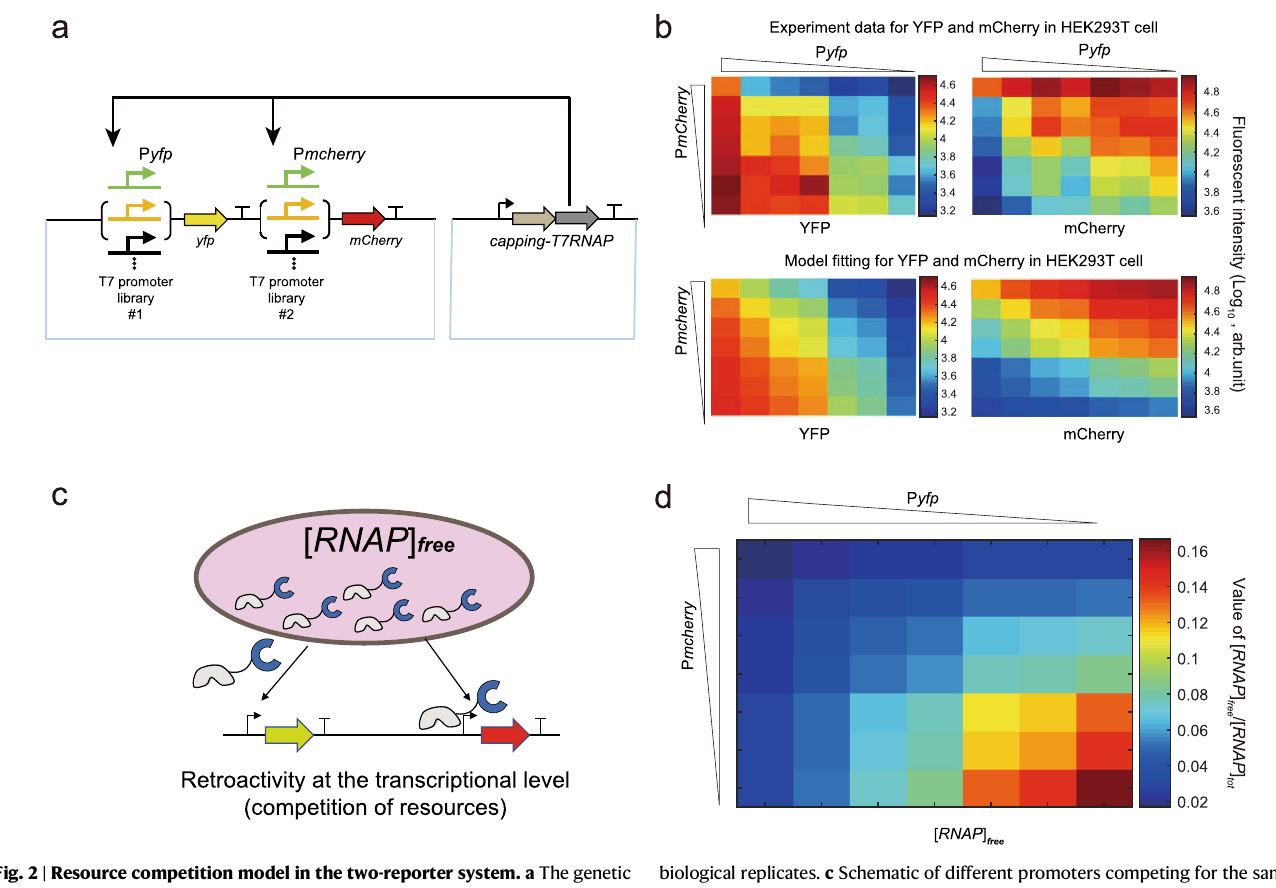
biological replicates. c Schematic of different promoters competing for the same pooloffreeRNAP([RNAP] free ). d Heatmapshowingtheconcentrationof[RNAP] free as calculated by the biochemical model with resource competition. Promoter activities are decreased as shown by the triangles for two reporter genes. Source data are provided as a Source data fi